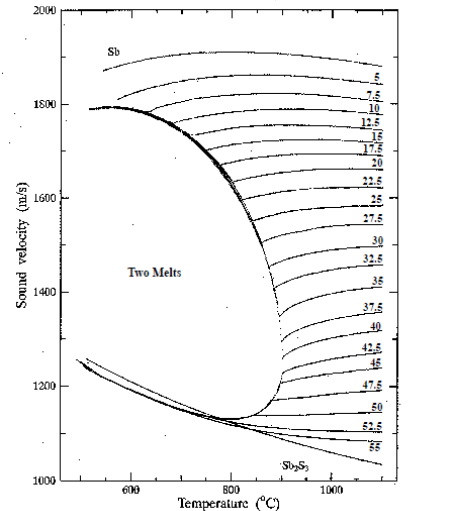
Fig. 1 Sound velocity in the Sb-Sb 2 S 3 system. The number on the curve indicates at.% S.